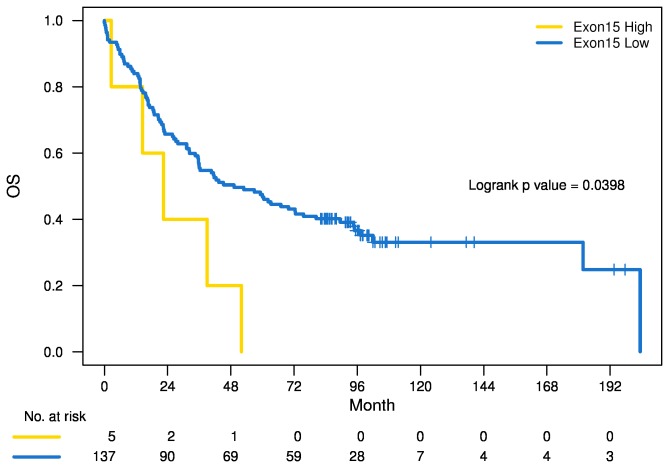
Kaplan-Meier overall survival estimates in the validation cohort.